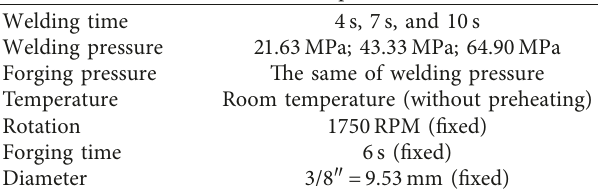
Table 3: Initial test parameters.